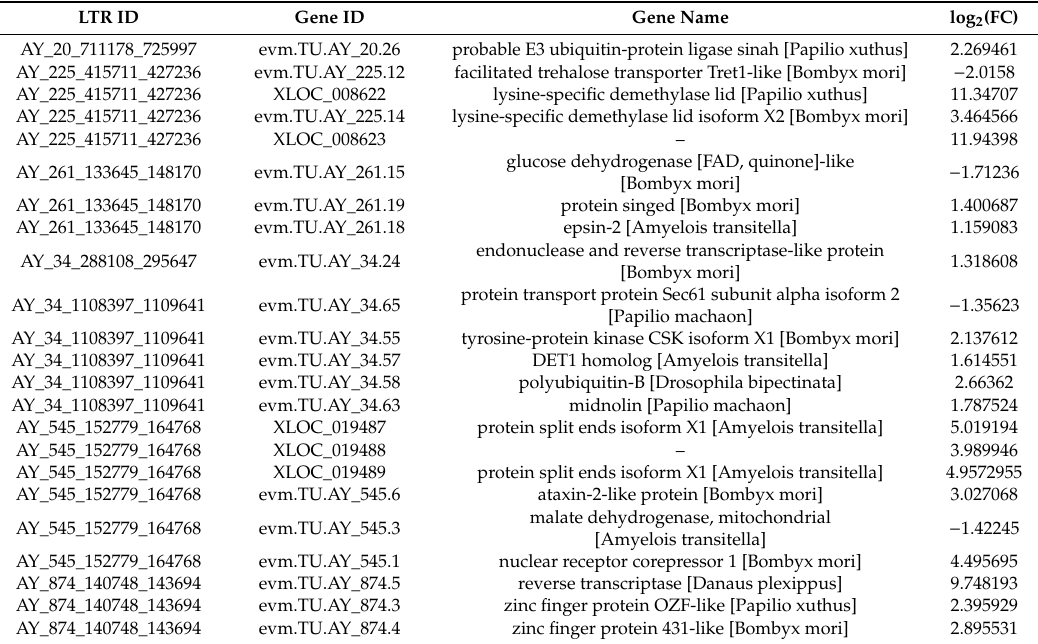
Figure 6. DELs-DEGs network obtained after comparison of ApNPV-infected A . pernyi samples with uninfected controls. DELs and their corresponding neighboring (putative cis -target) DEGs were used to construct a DELs-DEGs interaction network. In this network, up-regulated and down-regulated genes are displayed as red and green circles, respectively; similarly, up-regulated and down-regulated LTRs are displayed as red and green squares. Table 3. DEGs that are potentially cis -regulated by DELs during ApNPV infection.